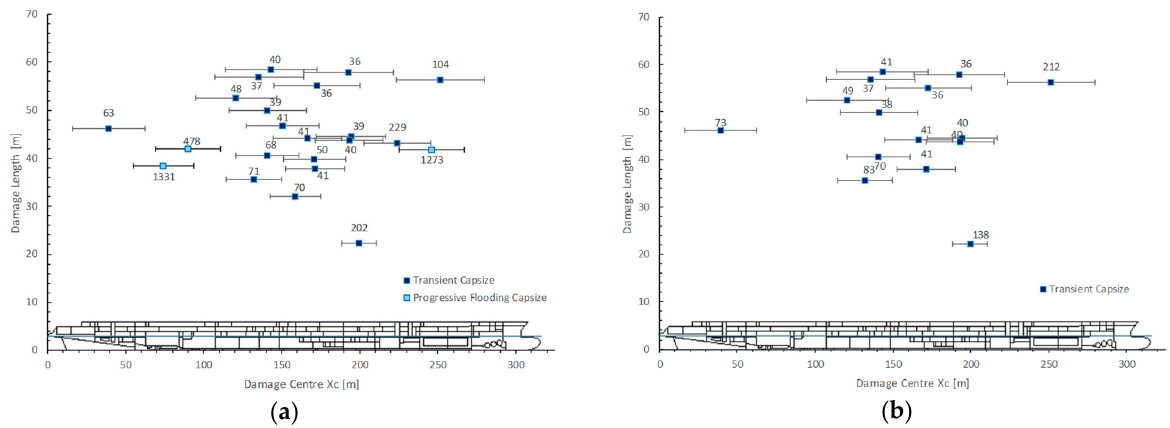
Figure 19. Residual loss scenarios. ( a ) Original layout, ( b ) AREST P1 reconfiguration.